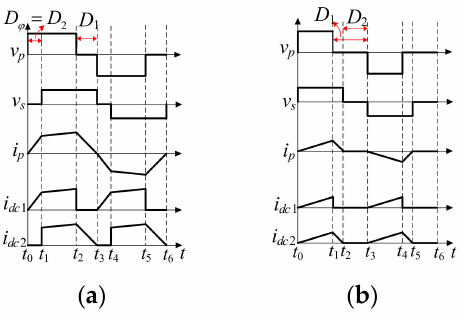
> (cid:104) i (cid:105) , dc 1 T S T S _ cri 1